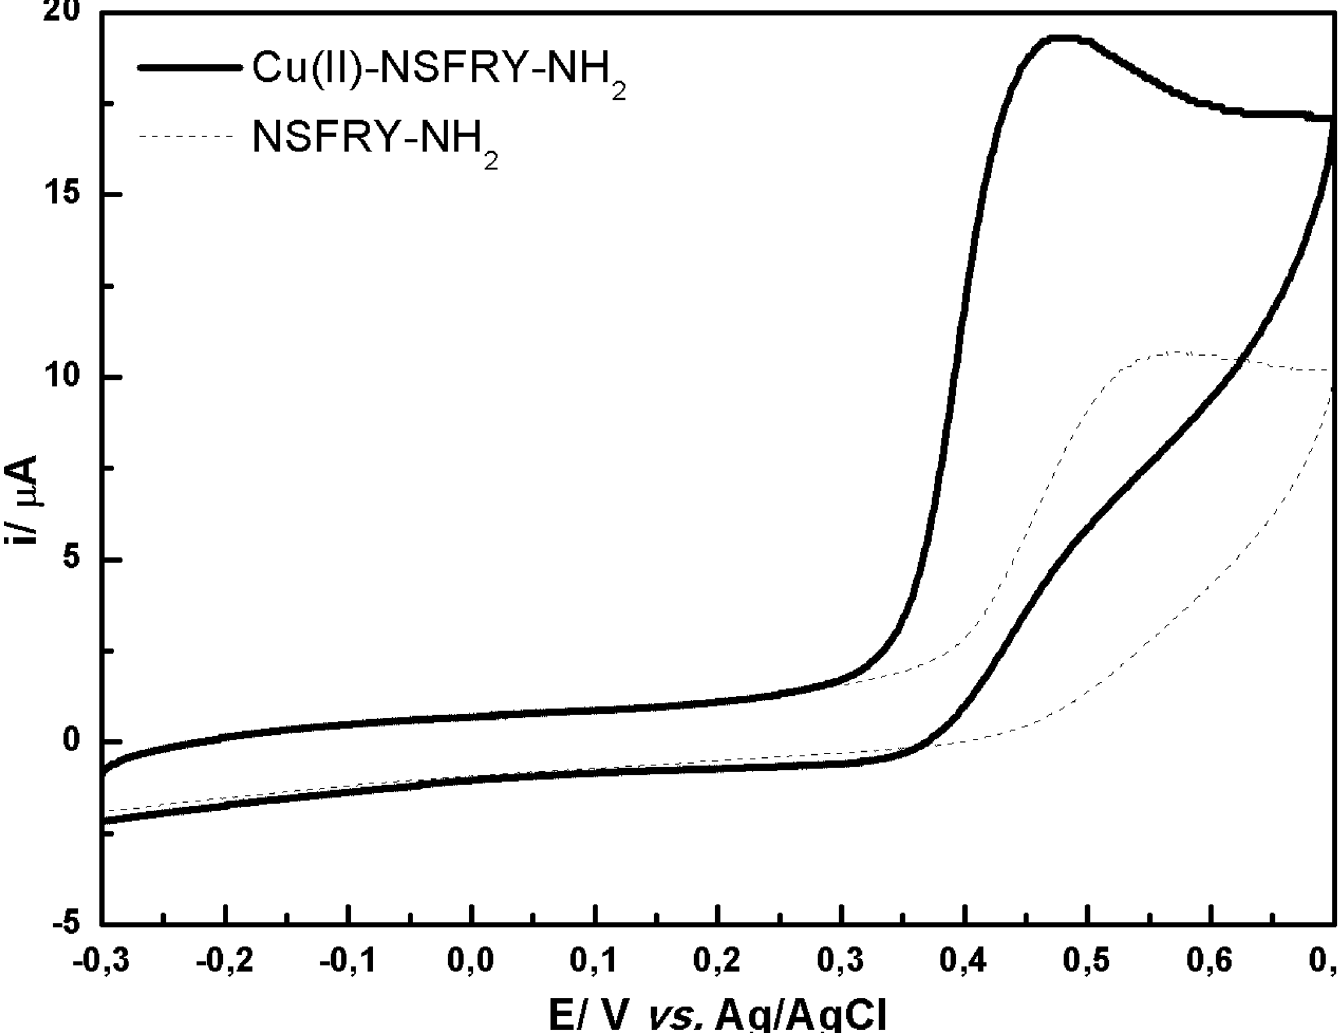
Fig 2. Cyclic voltammograms recorded in 0.5 mM aqueous solution of Cu(II)-NSFRY-NH 2 complex (solid line) and NSFRY-NH 2 peptide (dashed line) at pH 11.0.